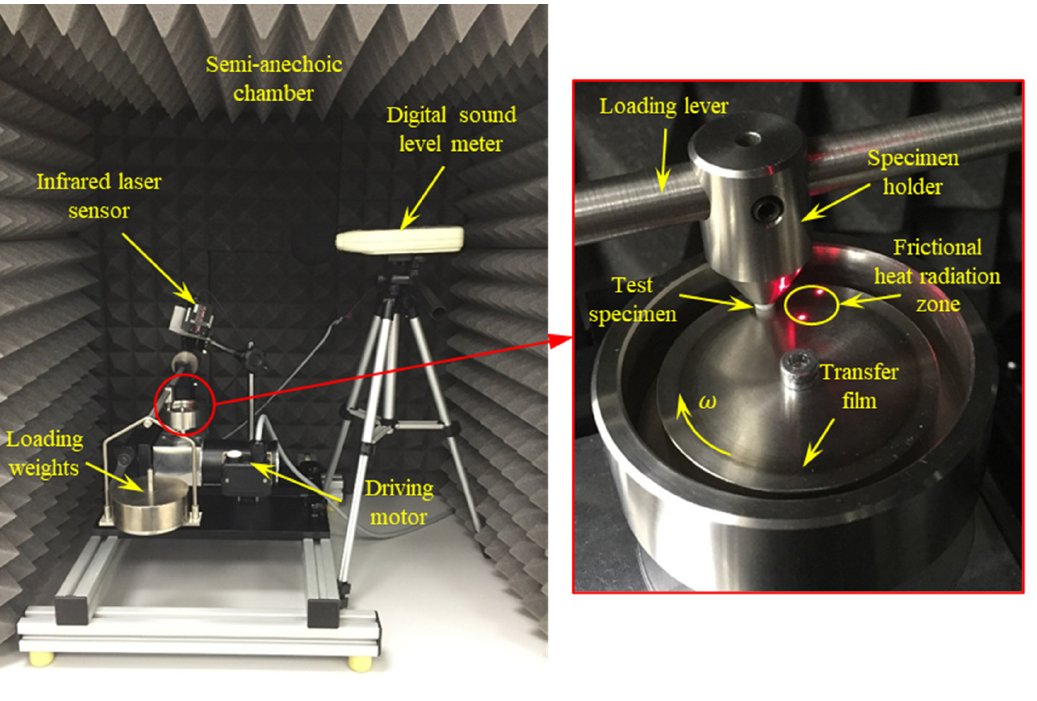
Figure 3. Experimental test rig with the pin-on-disc test apparatus. Table 2. Experimental conditions on the in-on-disc wear test apparatus.